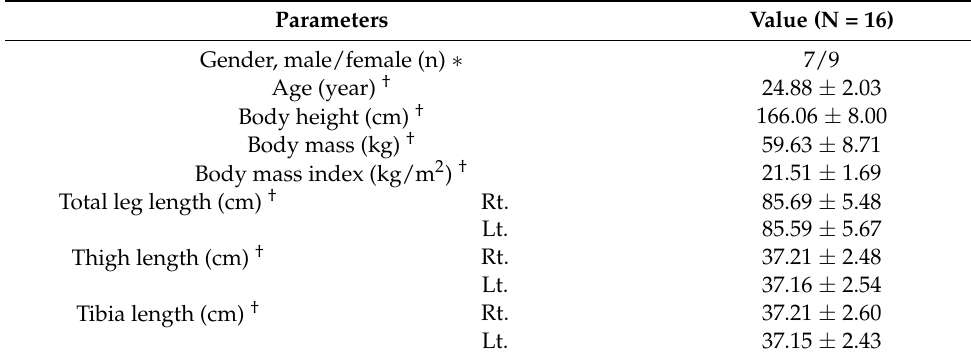
Figure 1. Consort flow diagram. Table 1. General characteristics of participants.